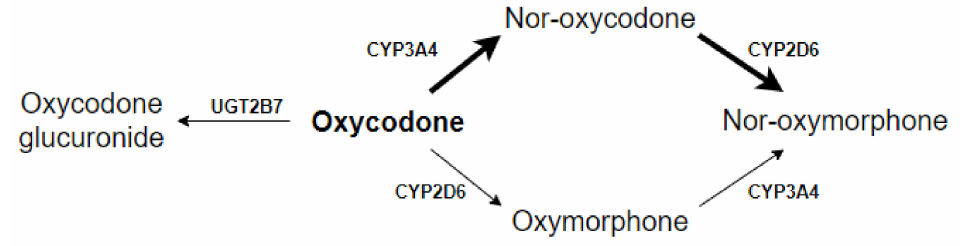
Figure 1. Schematic representation of oxycodone metabolism